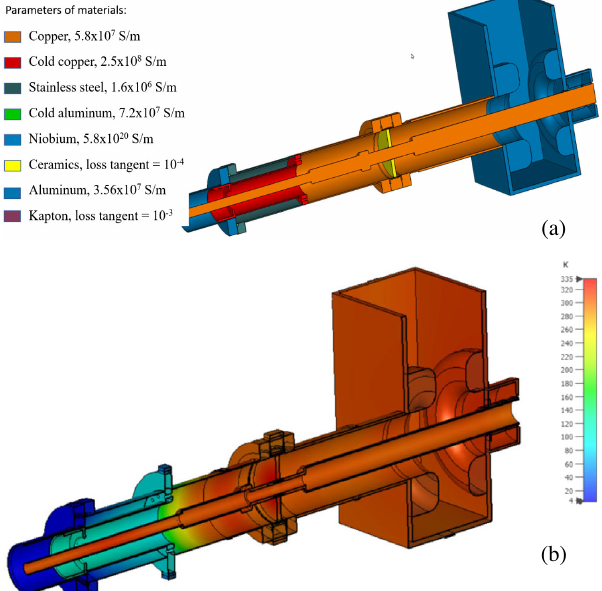
FIG. 17. Thermal analysis of the fundamental power coupler at 500 kW forward propagation (a) geometry and material proper- ties and (b) steady-state temperature